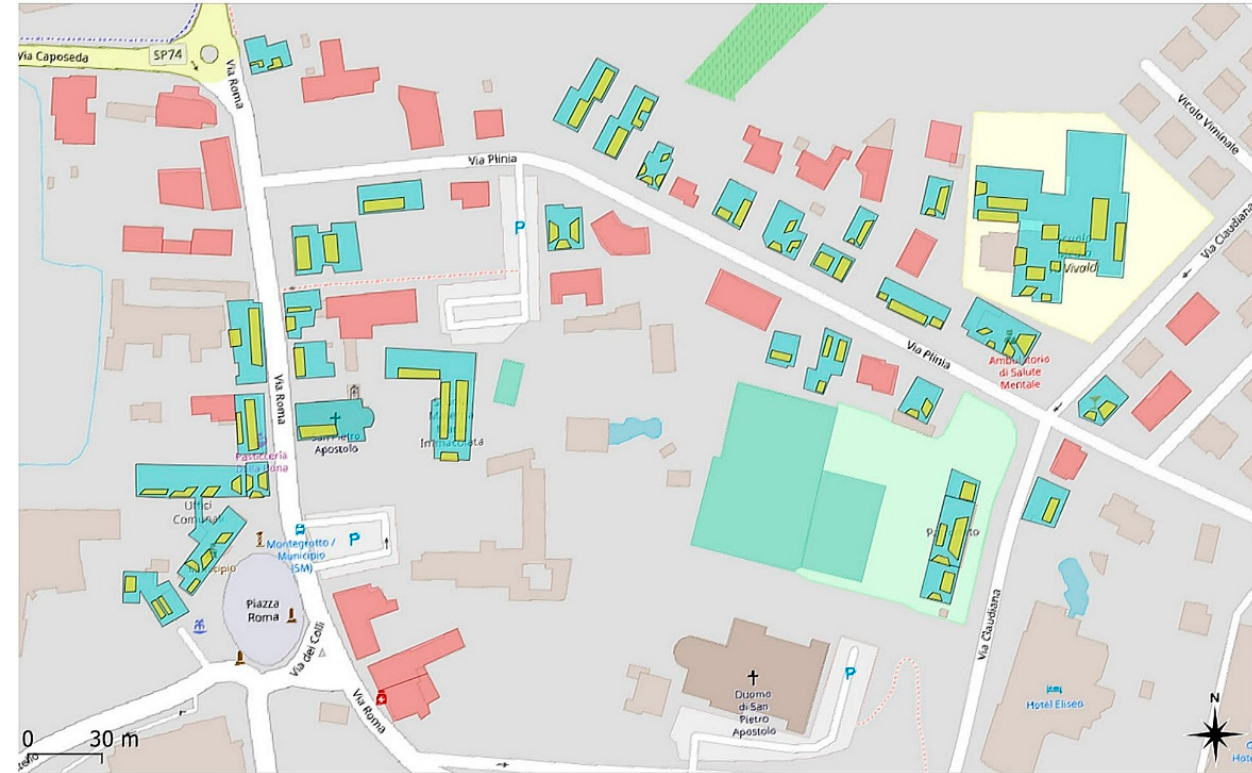
Figure 5. Map of the analyzed area in the Montenegro district of Italy (a group of 61 buildings). Table 2. Summary of the simulated scenarios.